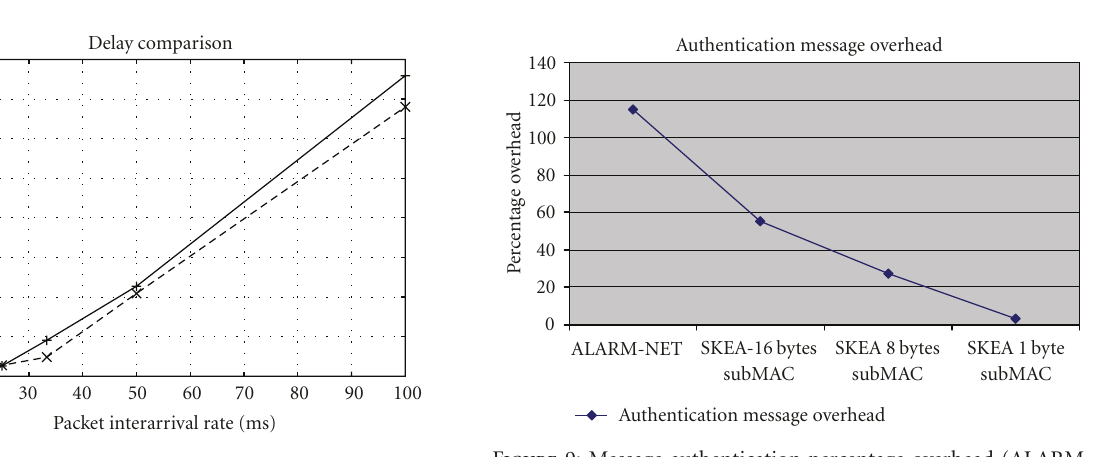
Figure 9: Message authentication percentage overhead (ALARM- NET versus